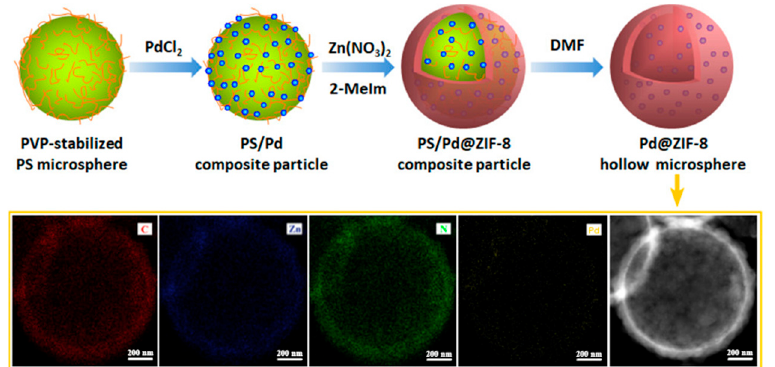
Figure 2. Schematic illustration of the fabrication process of a Pb@ZIF–8 hollow microsphere. Reprinted with permission from Ref. [28]. Copyright 2020, American Chemical Society.